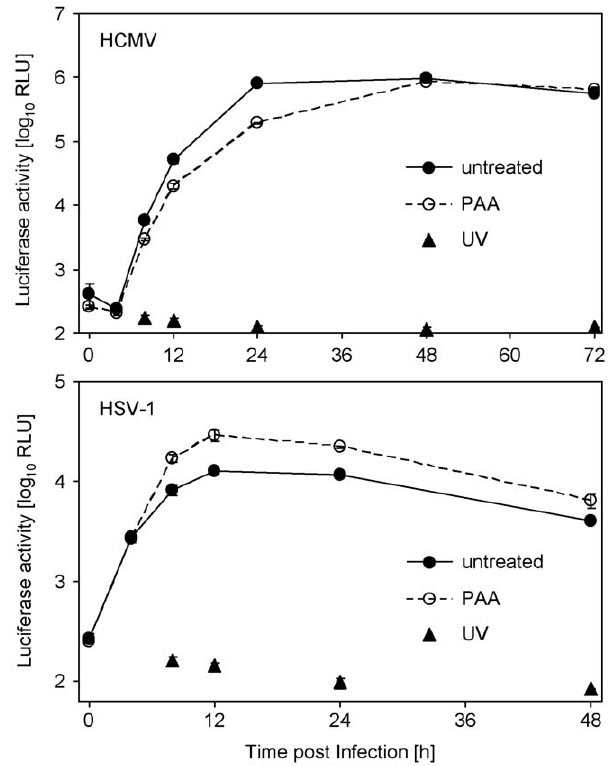
Figure 4. Time course of luciferase induction upon infection with HSV-1 and HCMV. MRC-5 cells were transfected with the pTA- Control plasmid by nucleofection and subsequently infected with HCMV-HB5 or HSV-1 F strain (4 PFU/cell). PAA was added at the time point of infection. Cells were lysed at indicated time points post infection and luciferase activity was measured.